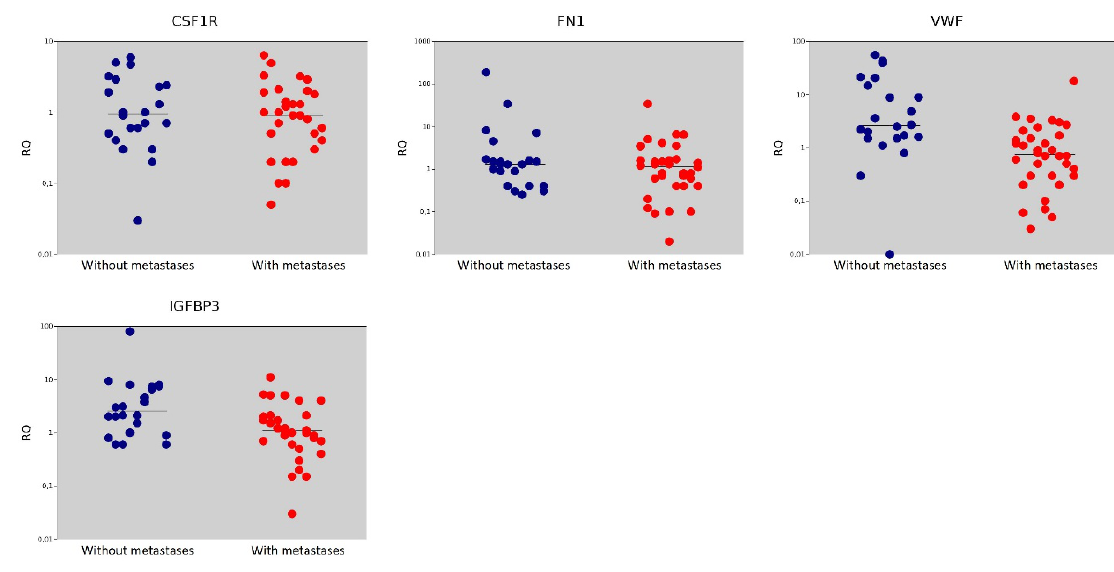
Figure 2. Relative gene expression (RQ) in groups with metastases ( ● ) and without metastases ( ● ). Gene expression values are presented on a logarithmic scale. The line marks the median.